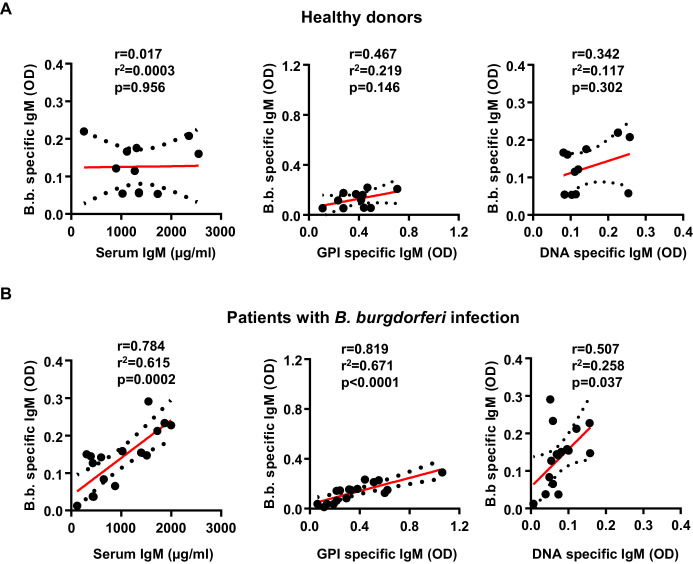
Induction of B. burgdorferi-specific and autoreactive antibody responses in humans.Shown is the correlation of serum IgM (µg/ml), glucose 6-phosphate (OD), and DNA specific (OD) IgM responses with B. burgdorferi specific IgM responses in healthy donors (n = 11) (A) and a cohort of patients with confirmed B. burgdorferi (n = 17) (B) infections. Graphs include all datapoints and the linear regression curve (red line) and error bar lines (depicting the SEM as black dotted lines). After testing for normal distribution of the individual data sets with a D’Agostino and Pearson normality test, the statistical evaluation for a correlation between the two parameters was performed with a Pearson’s correlation test. Pearson’s r, r2 and p values are indicated within each graph.